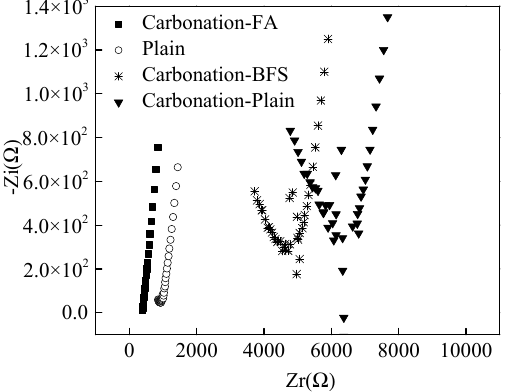
Figure 6. EIS curves of steel bars reinforce specimens.